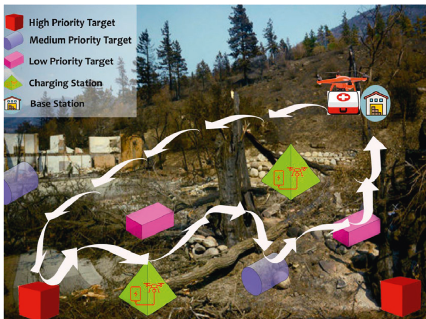
Figure 1: Typical drone route for delivering relief packages to the targets while stopping at charging